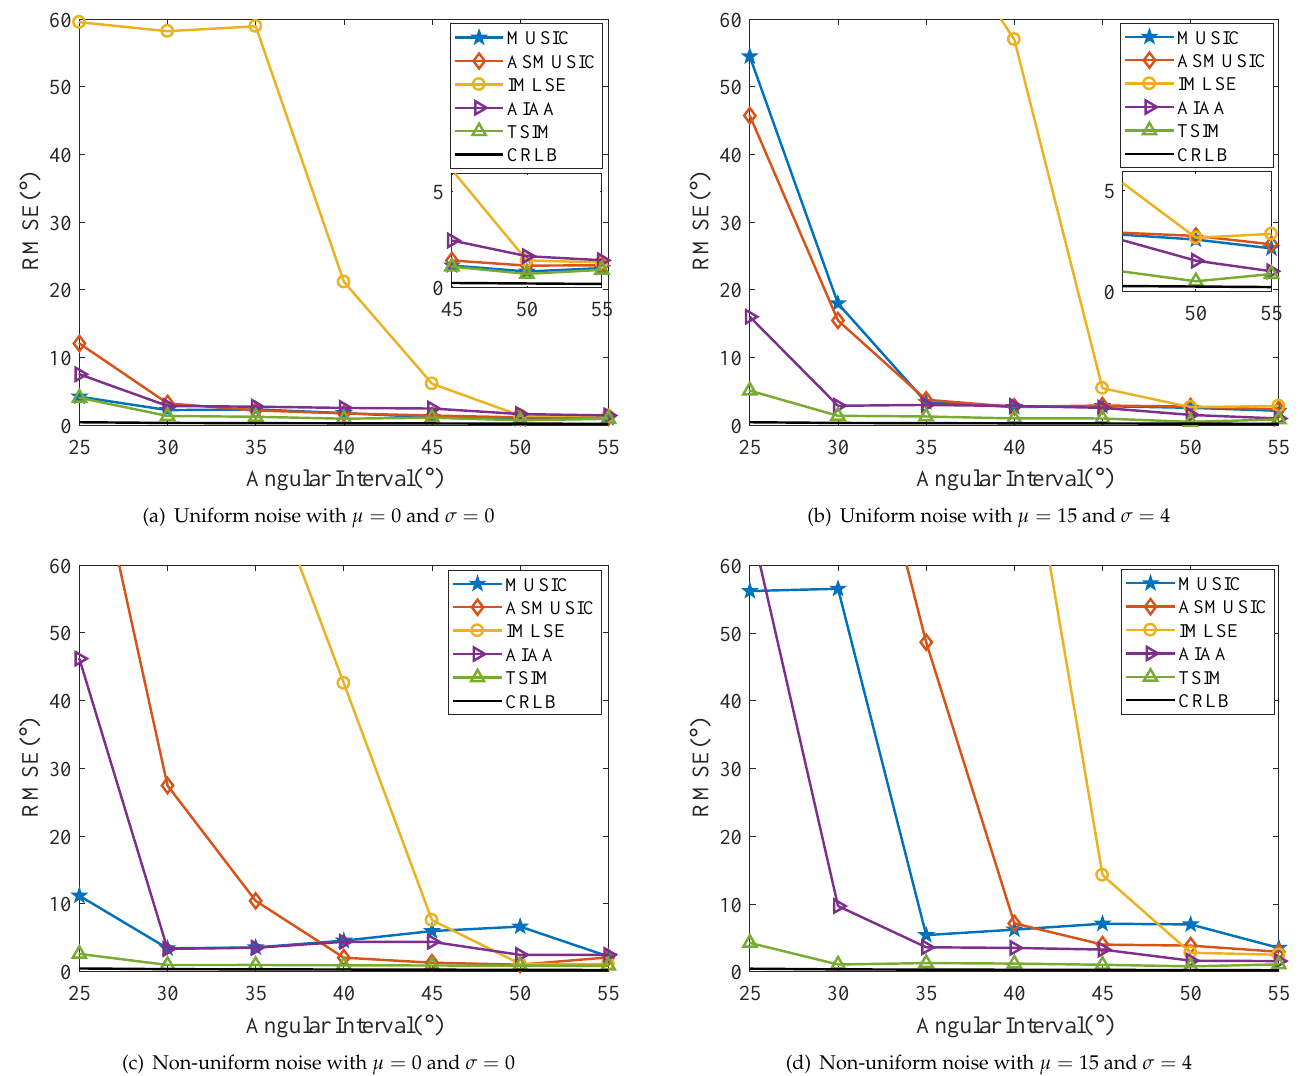
Figure 3. RMSE versus Snapshot with SNR = 0 dB and L = 300.